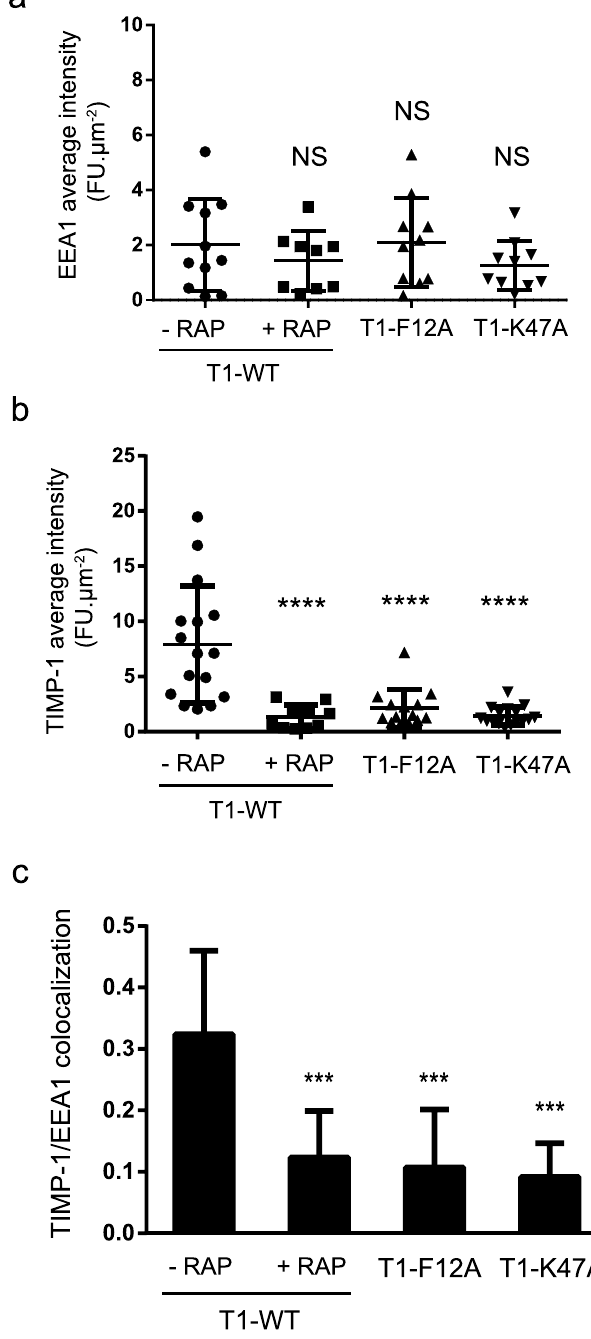
Figure 8. Quantification of TIMP-1 and EEA1 labelling. ( a ) Quantification of average intensity of TIMP-1 labelling per µ m 2 for each cell (n > 10) using ImageJ software. The data are representative of at least three independent experiments with at least five mice embryos. Error bars indicate mean ± SD and **** indicates significantly different from T1-WT without RAP and with a P-value < 0.0001. ( b ) Quantification of average intensity of EEA1 labelling per µ m 2 for each cell (n > 10) using ImageJ software. Error bars indicate mean ± SD and NS indicates a value that is not statistically significant. ( c ) Quantification of TIMP-1/EEA1 colocalisation (n > 10) calculated using AMIRA software. Error bars indicate mean ± SD and *** indicates significantly different from T1-WT without RAP with a P-value <